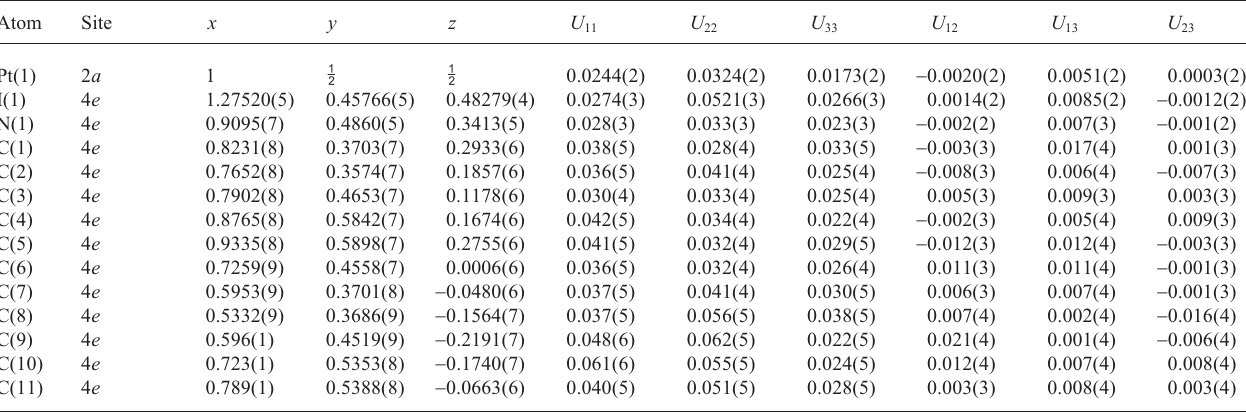
Table 3. Atomic coordinates and displacement parameters (in Å 2 )